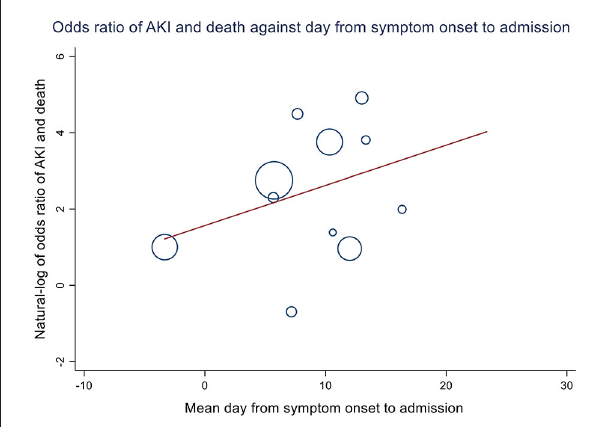
FIGURE 5 | Association between days from symptom onset to admission and odds ratio of death and acute kidney injury. Eleven studies from China, Italy, Spain, Germany, and Turkey were included (2,097 patients). Each day longer between symptom onset and admission was associated with a 12% increase in the odds of death among acute kidney injury (AKI) patients across population, although not statistically significant (OR = 1.12, 95% CI = 0.90–1.38, p =